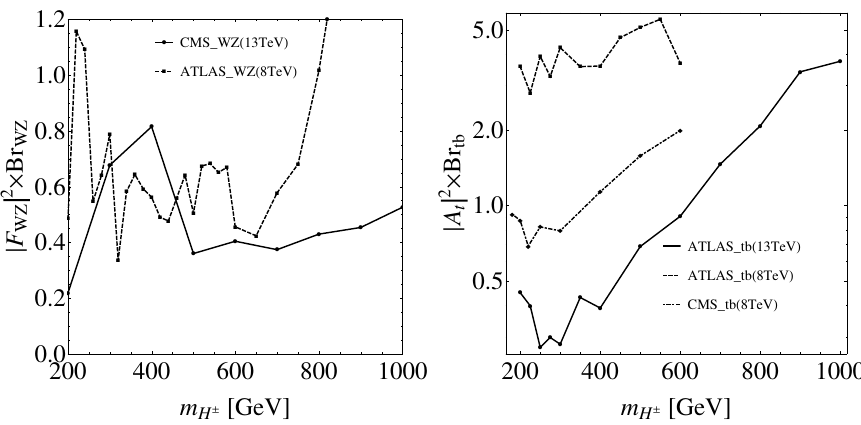
Figure 4 . Constraints on j F WZ j 2 (cid:2)B WZ (left panel) and j A t j 2 (cid:2)B tb (right panel) from the existing charged Higgs boson searches at the